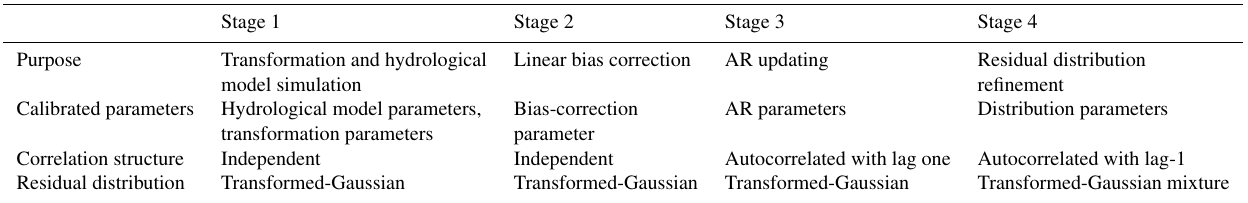
Table 1. Summary of the ERRIS